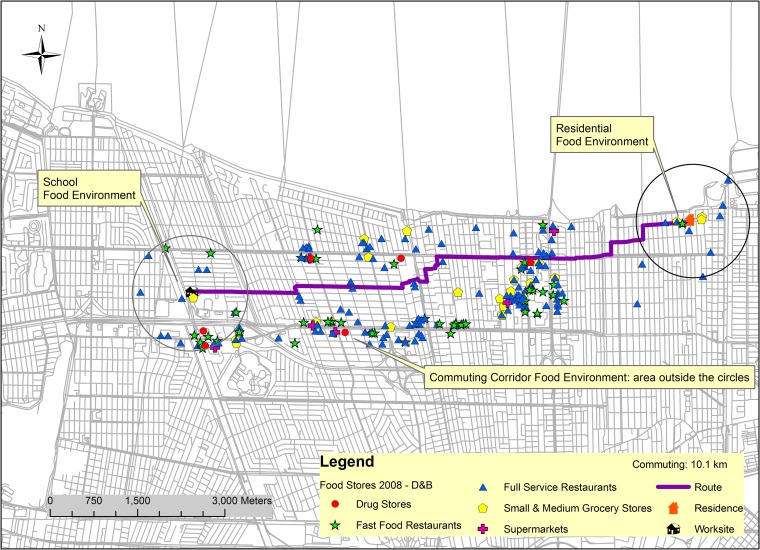
Map of food establishment locations in all 3 food environments for a fictitious participant in the greater New Orleans, LA region in 2008.